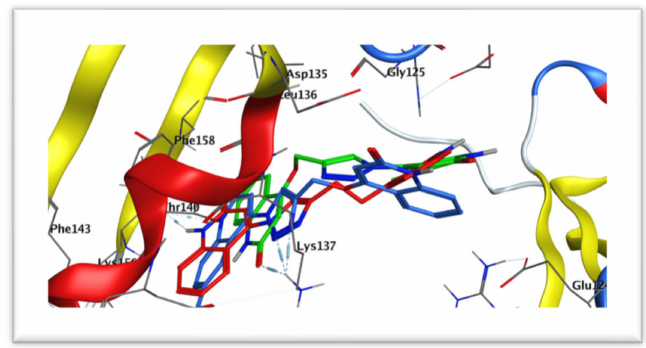
Figure 15. Docking of compounds 6a (red) aligned with 6b (blue) and 6c (green) within the active site of caspase-3 (PDB: